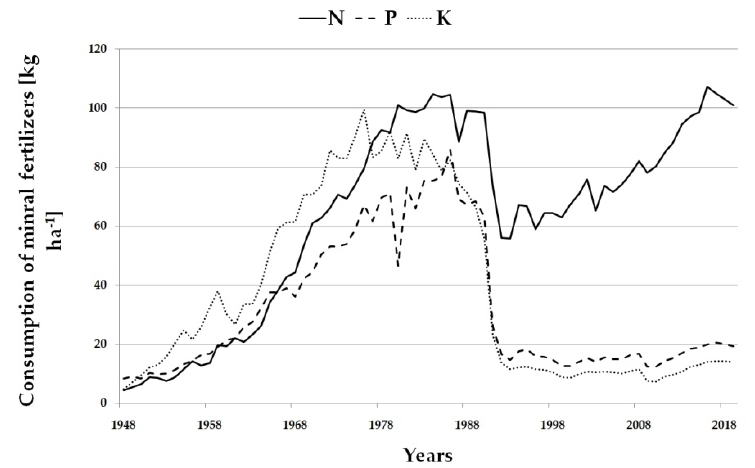
Figure 6. The mean consumption of mineral fertilizers (N, P, K, kg ha − 1 ) in the Czech Republic (1948–2019).